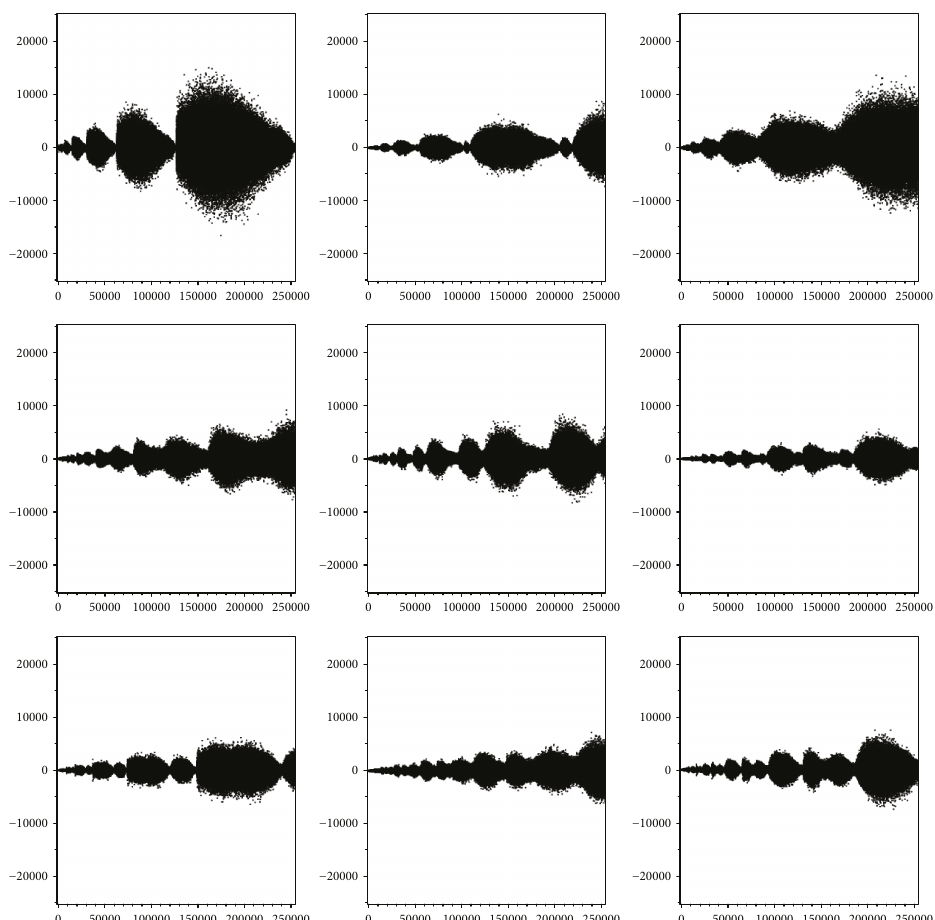
Figure 3: Scatterplots of S n , α k , S n , and α k , S 4,2 7,2